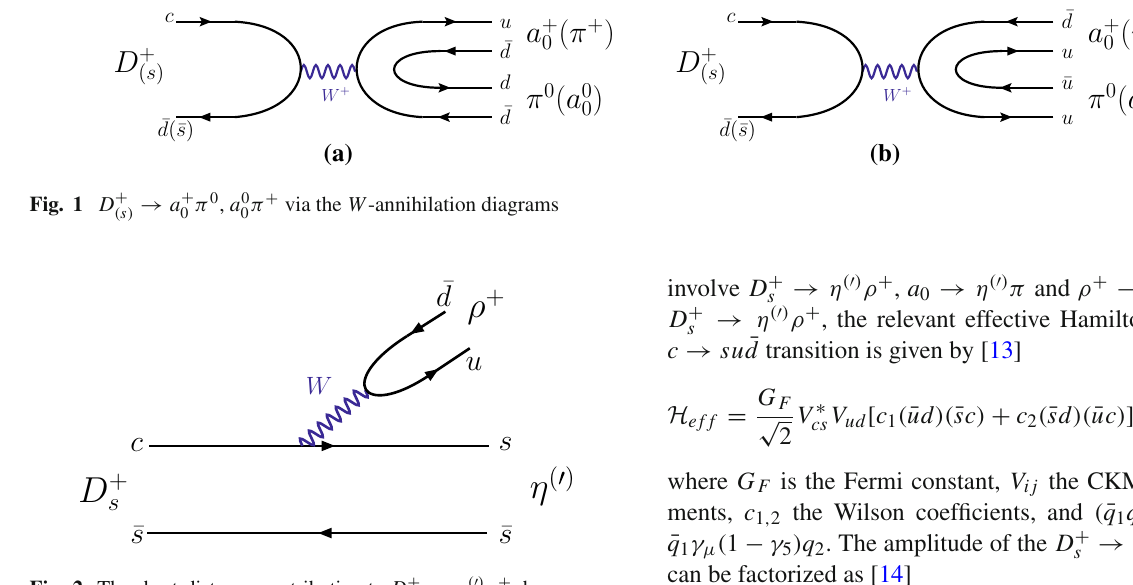
Fig. 2 The short-distance contribution to D + s → η ( (cid:3) ) ρ + decay